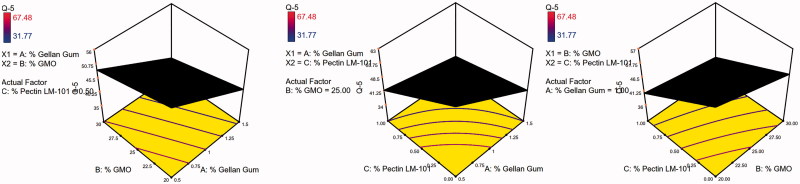
3D surface plot of GBP raft floating formulae after 5 h release in 0.1 N HCl.